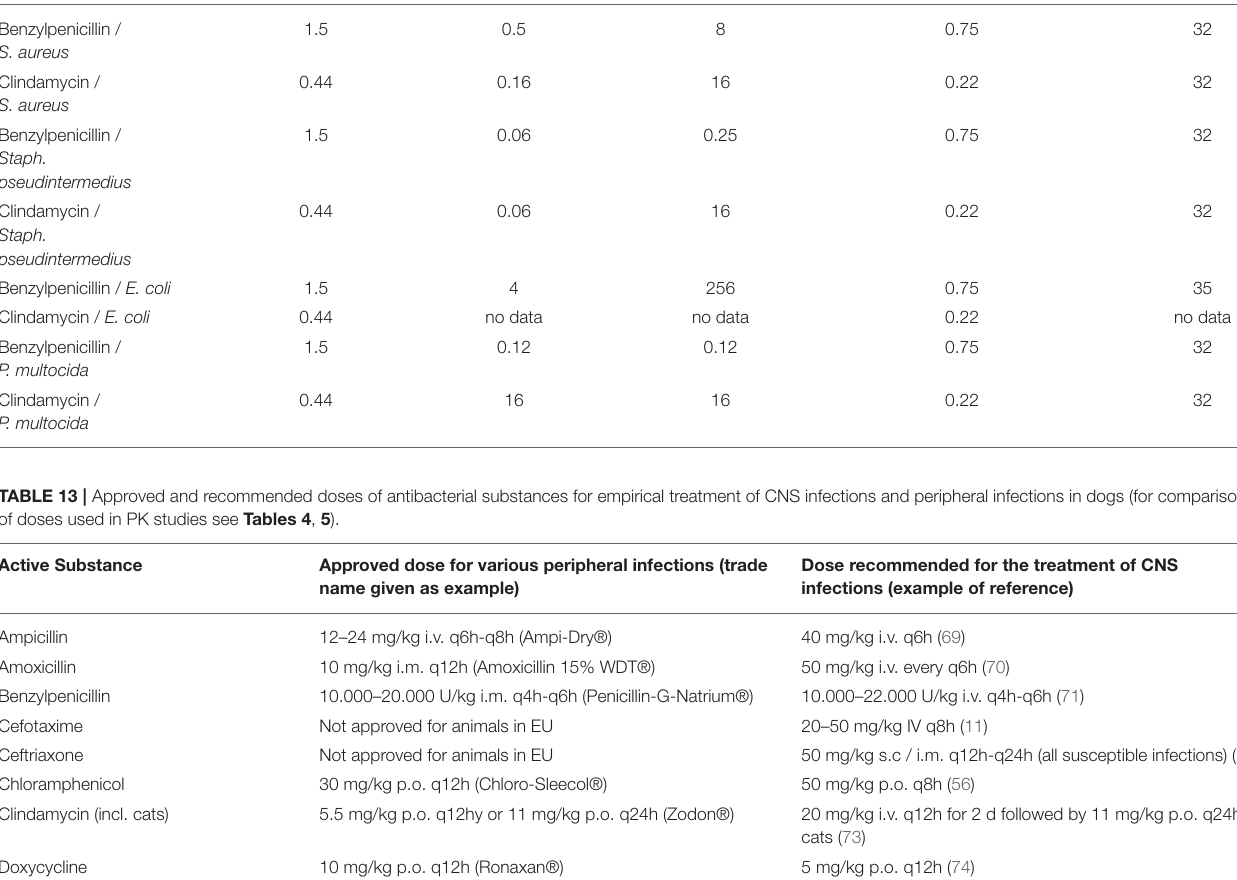
TABLE 12 | C max in CSF in cats after the administration of benzylpenicillin or clindamycin and selected PK-PD cutoffs of four bacterial pathogens. Antibiotic / Pathogen